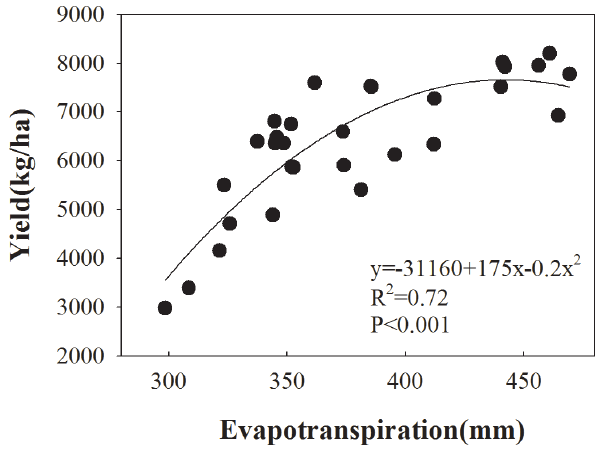
Figure 2. Relationship between wheat evapotranspiration (ET) (mm) and grain yield (Y) (kg/ha) for winter wheat in northwest China. The relationship between ET and yield is shown by the